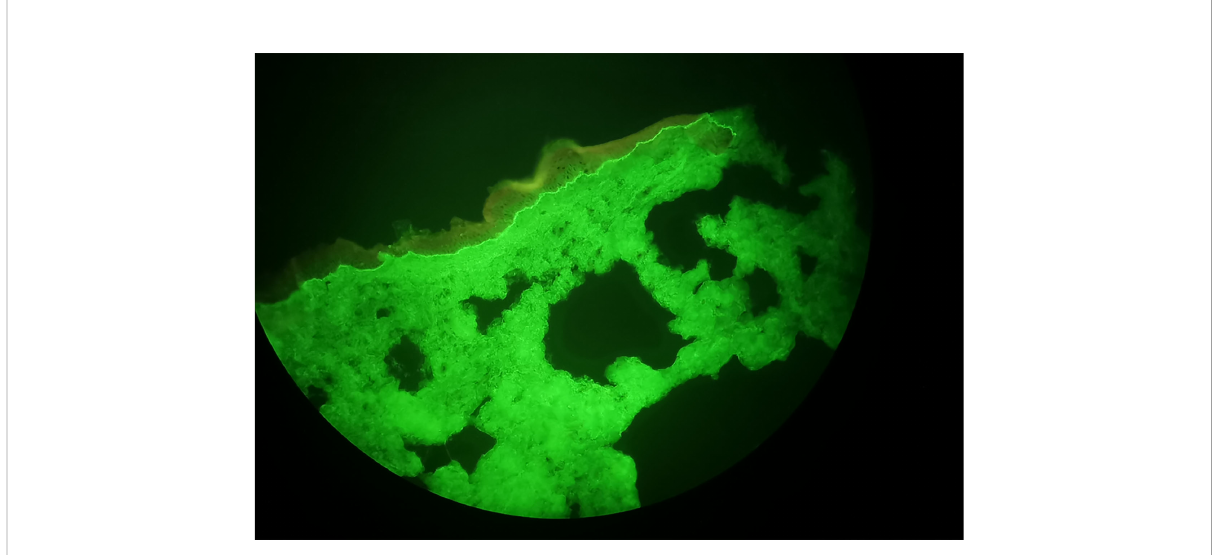
FIGURE 1 Direct Immuno fl uorescence consistent with Bullous Pemphigoid Diagnosis.